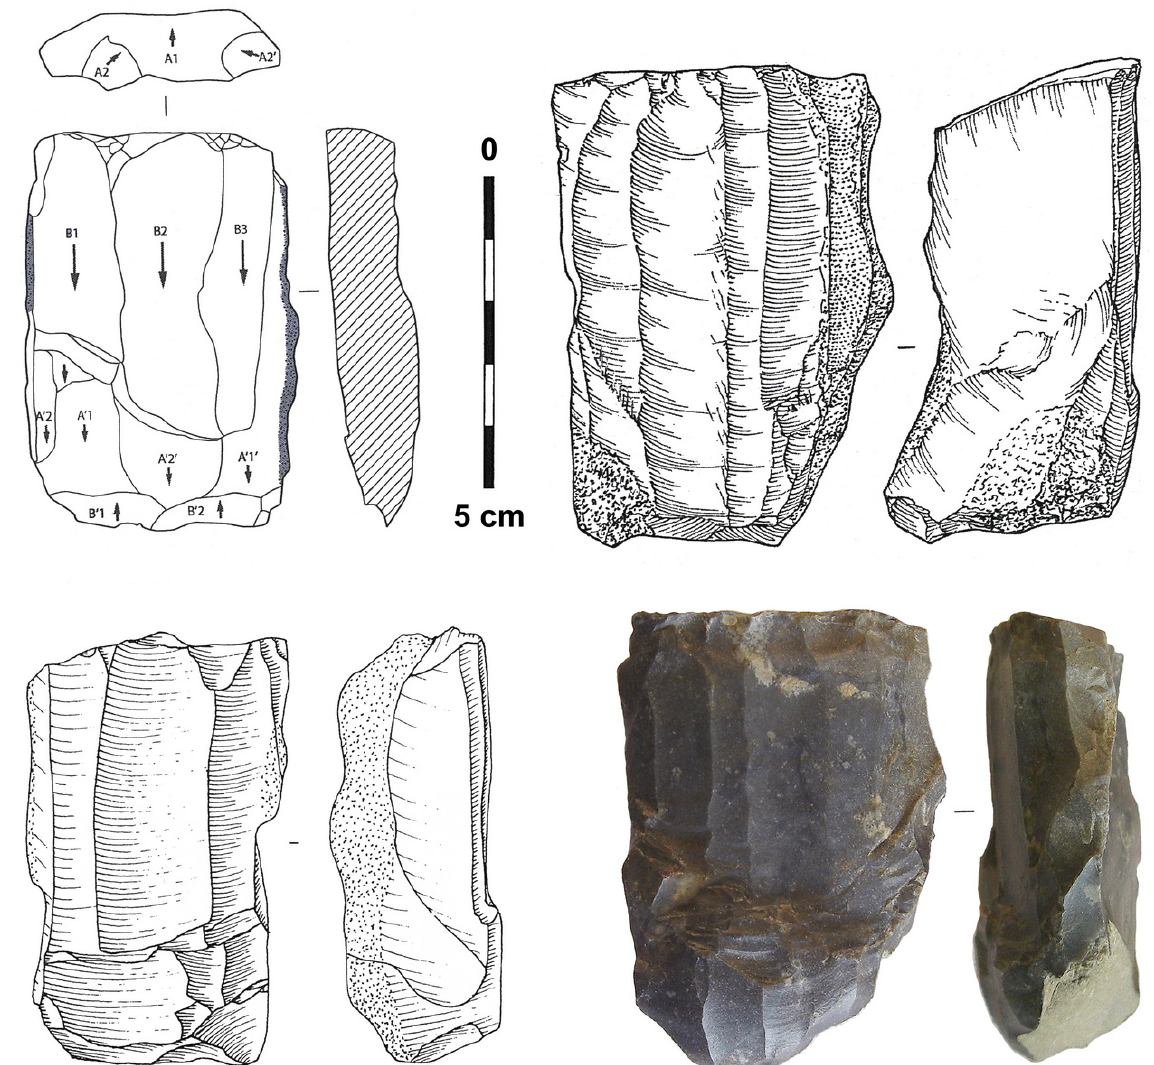
Figure 8. Nucléus à lamelles à table quadrangulaire et flancs orthogonaux des Essarts (Marchand 2009), Lhéry (Bostyn & Seara 2011), Ruffey-sur-Seille « A Daupharde » (Seara et al. 2002) et Oeudeghien (Crombé et al. 1992) (photo: P. Allard). Figure 8. Core with quadrangular bladelet surface and orthogonal flanks of the Essarts (Marchand 2009), Lhéry (Bostyn & Seara 2011), Ruffey-sur-Seille “A Daupharde” (Seara et al. 2002) and Oeudeghien (Crombé et al. 1992) (photo: P.